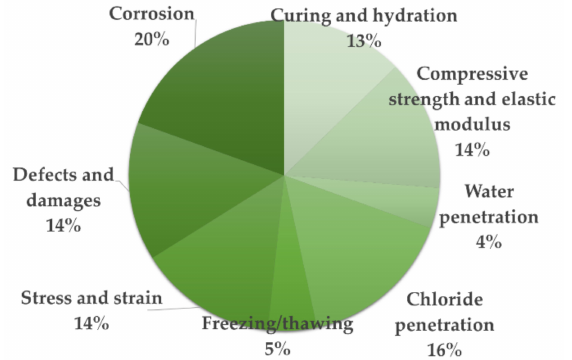
Figure 4. Di ff erent electrodes configurations used for electrical resistivity measurement in terms of ( a ) Materials and ( b ) Geometries.